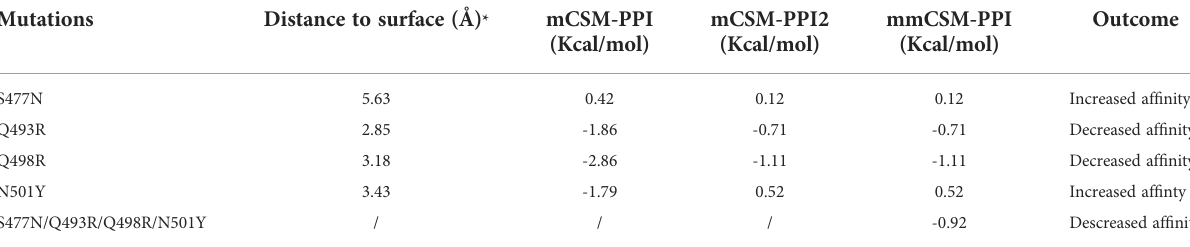
*Distance to surface is a measurement from the wild-type residue to the binding interface between Spike and ACE2 in the homology model, to indicate the biochemical property of the mutation, which is not used to measure of the binding.